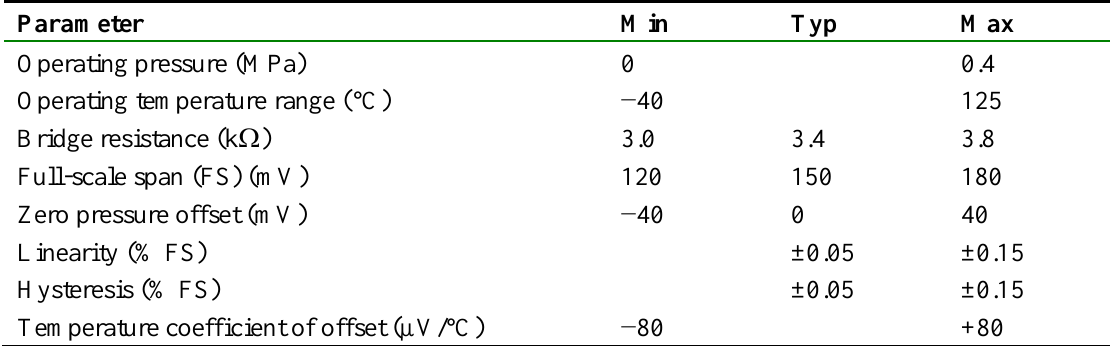
Table 3. Some typical characteristics of the MS7904A silicon pressure sensor